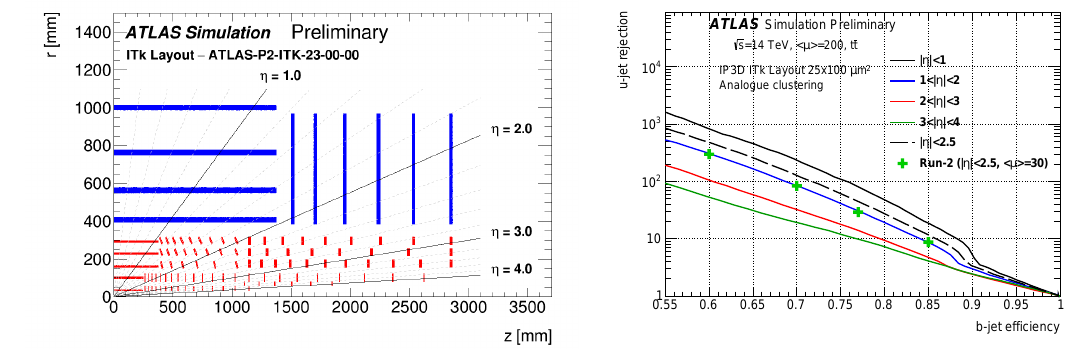
Figure 3: The all-silicon ITk tracker provides full coverage up to | η | = 4.0 with strip and pixel detectors (left) [ 10 ] , resulting in improved b -jet tagging efficiency relative to the current ATLAS detector (right) [ 11 ]